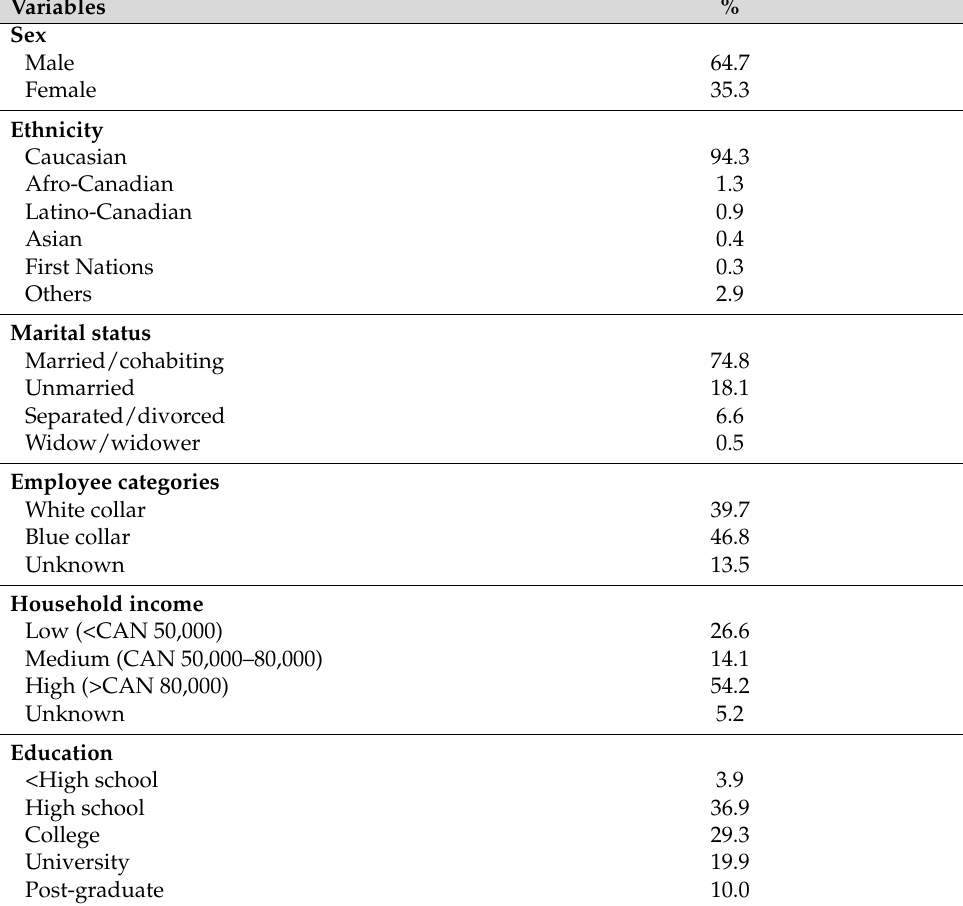
Table 1. Employees’ sociodemographic